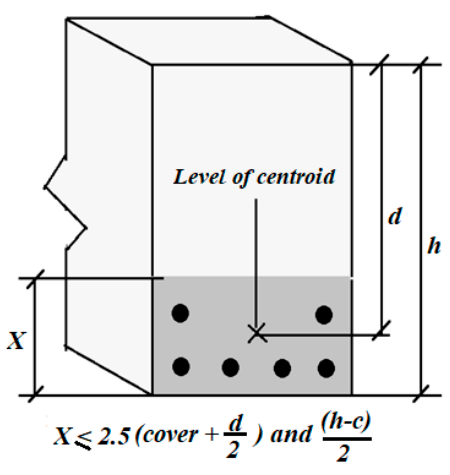
4 of 27 Figure 2. Calculation of the effective area to determine the flexural crack spacing, according to NS 3473E 2003 [54]. CSA S474 [53] and NS 3473E [54] propose a similar formula to anticipate the crack spacing, with little variance in the slope of strain, which calculates the effective rebar’s section. According to NS 3473E [54], the crack spacing is determined using the following relationship. (cid:1849) (cid:3038) ، (cid:3015)(cid:3020) = 1.7(cid:1849) (cid:3040) ، (cid:3015)(cid:3020) ; (cid:1849) (cid:3040) ، (cid:3015)(cid:3020) = (cid:1870)(cid:1875)(cid:2013) (cid:2869) (cid:1845) (cid:3040) ، (cid:3041)(cid:3046) , (3) (cid:1870) = 1 − (cid:2010) 2.5(cid:1863) (cid:2869) (cid:3436) (cid:2026) (cid:3046)(cid:3045) (cid:2026) (cid:3046) (cid:3440) (cid:2870) ≥ 0.4,